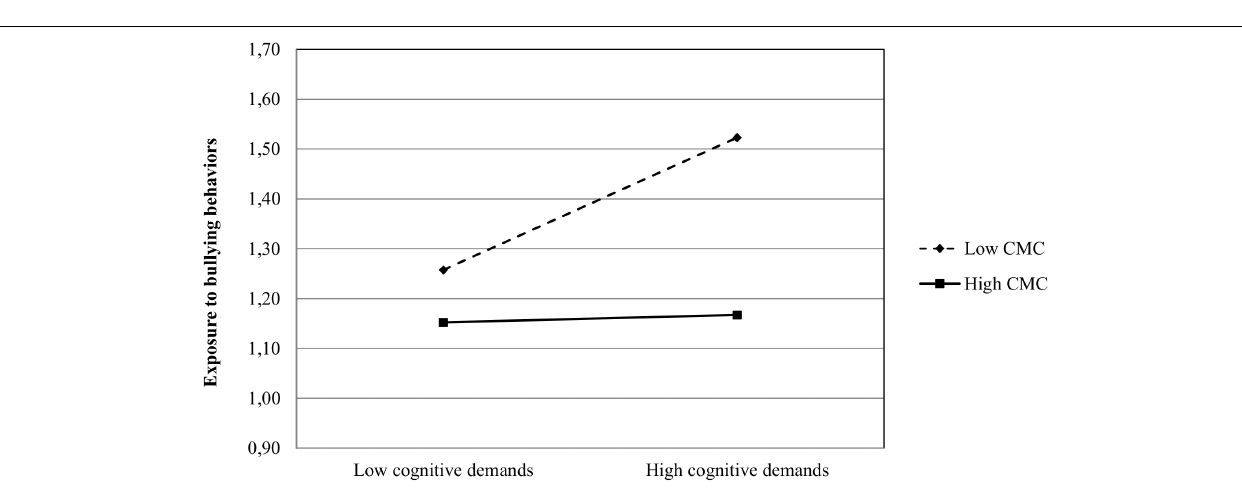
FIGURE 2 | Plot of the interactive relationship of cognitive demands and bullying behaviors in teams with weak vs. strong CMC. CMC, conflict management